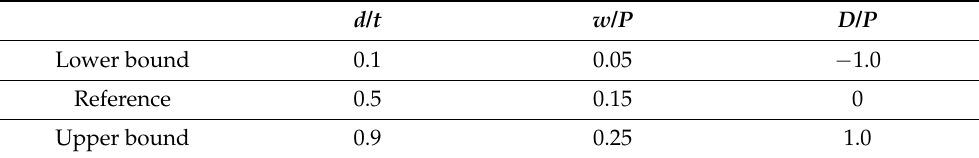
Table 2. Ranges of design